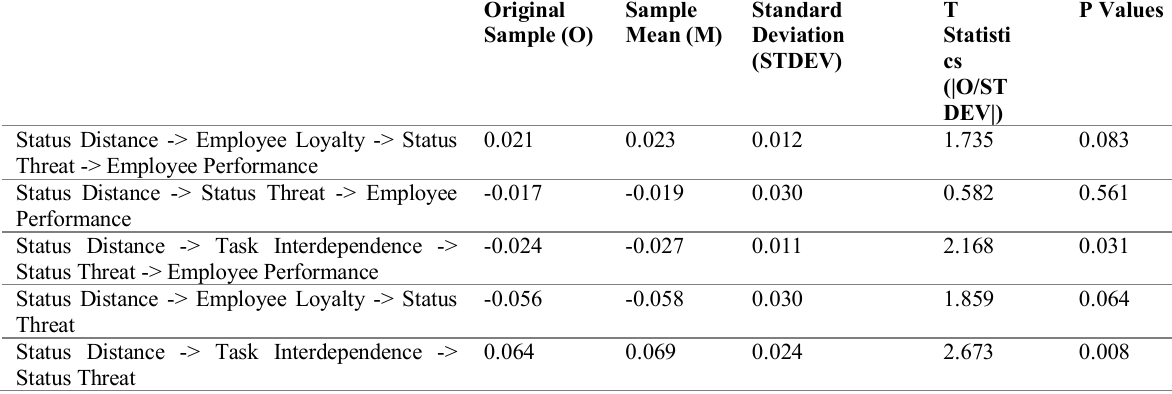
Table 3 : Specific indirect